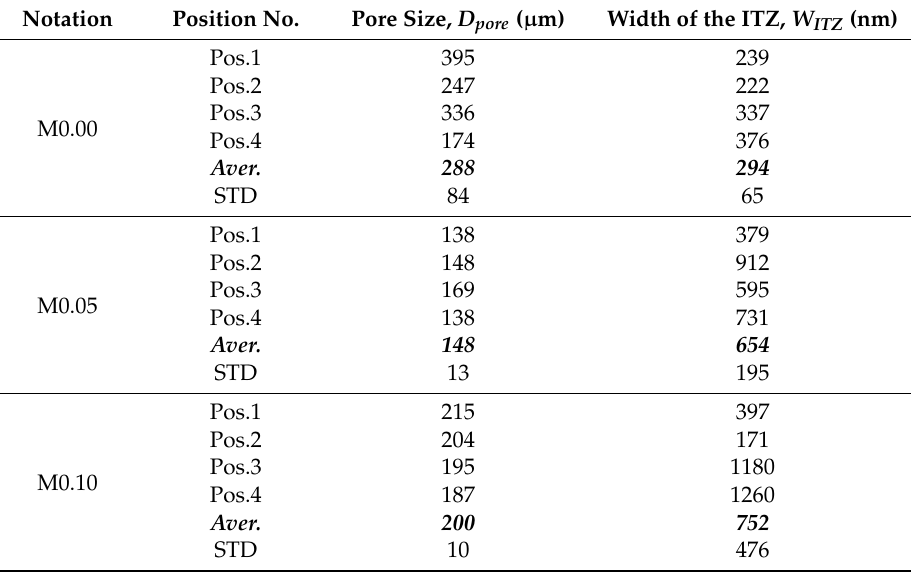
Table 7. Pore sizes and widths of the interfacial transition zone